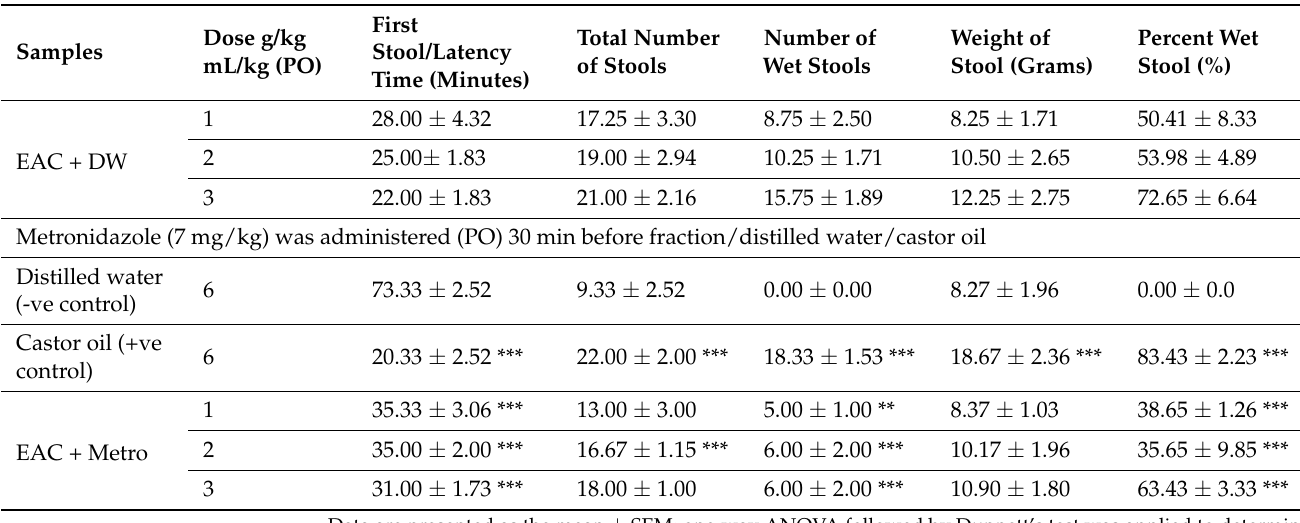
Table 5. Diarrheal/laxative activity of EAC.